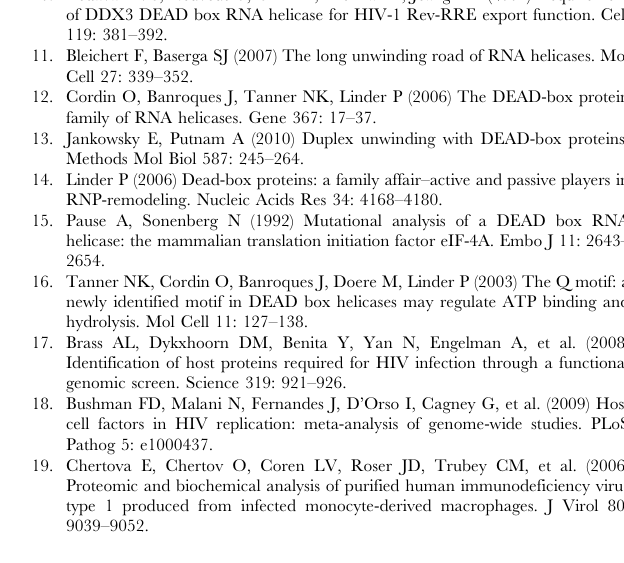
ELISA. Data in A and B represent mean 6 S.D. (error bars). Figure S2 The effect of DDX5 on the transcription of reporter genes. A and B . The 293T cells were co-transfected with pDM628 ( A ) or pRL-TK ( B ) and differing amounts of pcDNA3.1-DDX5-HA (pcDNA3.1 as a control), respectively. Total RNA was extracted from the transfected cells and analyzed with qRT-PCR using primers specific to firefly luciferase mRNA or renilla luciferase mRNA. Data in A and B . represent mean 6 S.D. (error bars). Figure S3 The effect of DDX5 knockdown on HIV-1 mRNA splicing. The 293T cells were co-transfected with pNL4- 3 D Env-GFP and DDX5-siRNA (GFP-siRNA as a control), respectively. Total RNA was extracted from the transfected cells and analyzed with qRT-PCR using primers specific to rev mRNA, tat mRNA or gag-pol mRNA. Data represents mean 6 S.D. (error bars).